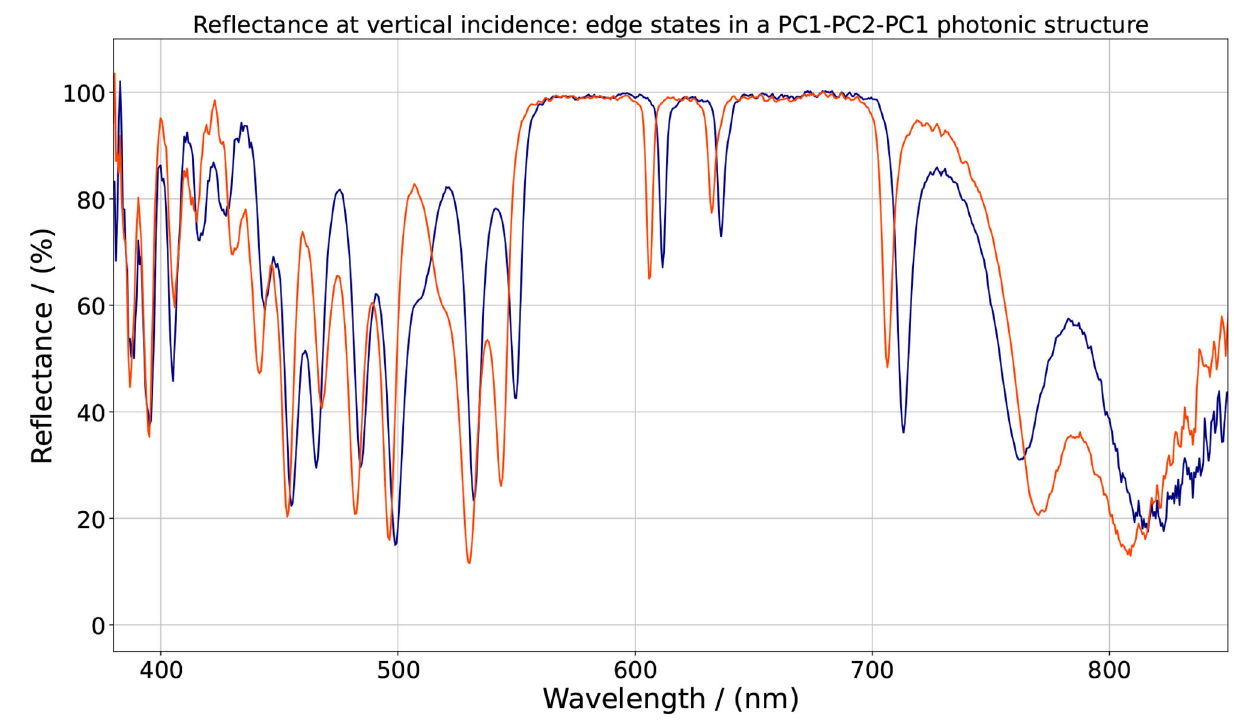
Frontiers in Nanotechnology |